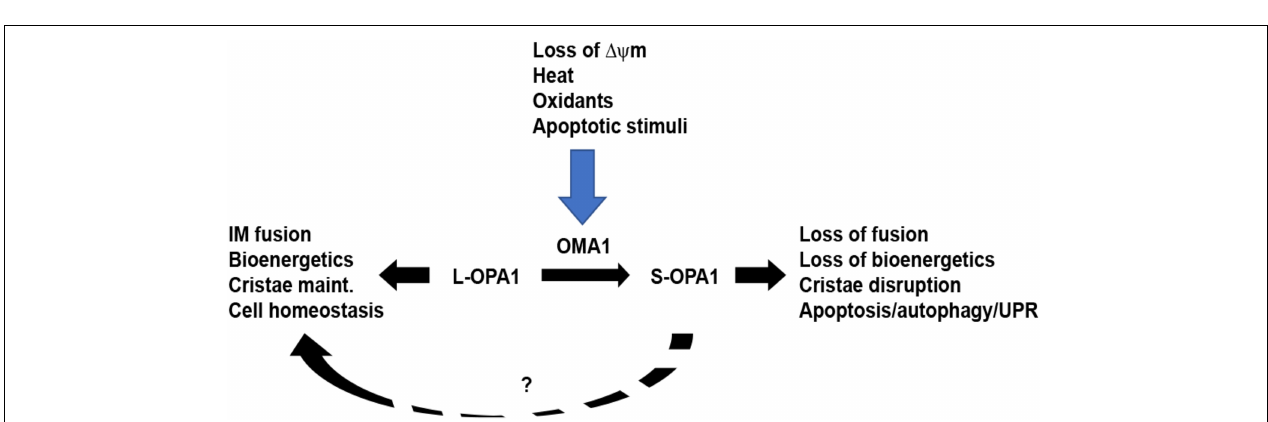
FIGURE 2 | OMA1 controls stress-sensitive cleavage of long OPA1 isoforms. Under steady-state conditions, mitochondria maintain a balance of long, fusion-active L-OPA1 and short, fusion-inactive S-OPA1 isoforms. While YME1L (not shown) causes constitutive cleavage of L-OPA1 to produce steady-state S-OPA1, the OMA1 metalloprotease is activated by a range of stress stimuli. Upon activation, OMA1 cleaves L-OPA1, causing accumulation of S-OPA1, mitochondrial fragmentation, and loss of mitochondrial bioenergetics. This, in turn, primes the cell for increased stress response via mechanisms including apoptosis, autophagy, and unfolded protein response. While S-OPA1 isoforms cannot mediate mitochondrial inner membrane fusion, they may contribute to maintaining mitochondrial homeostasis (dashed line,